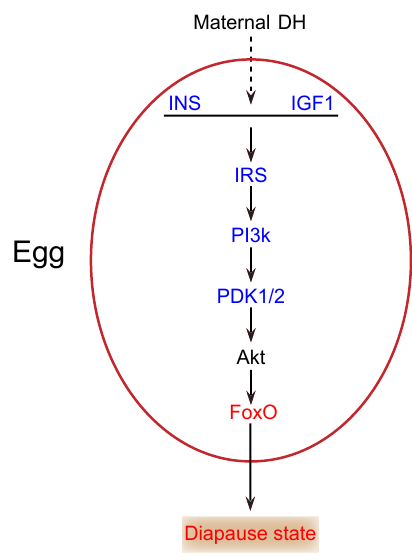
Figure 6. Potential insulin / FoxO signaling pathway in silkworm diapause eggs at onset of diapause. Blue text indicates downregulation, red text indicates upregulation, and black text indicates that neither up- nor downregulation was confirmed in this study. INS, insulin; IGF1, insulin-like growth factor 1; IRS, insulin receptor substrate 1-B; PI3k, phosphatidylinositol 3-kinase 60; DH, diapause hormone; PDK1 / 2, 3-phosphoinositide-dependent protein kinase 1; FoxO, Forkhead box protein